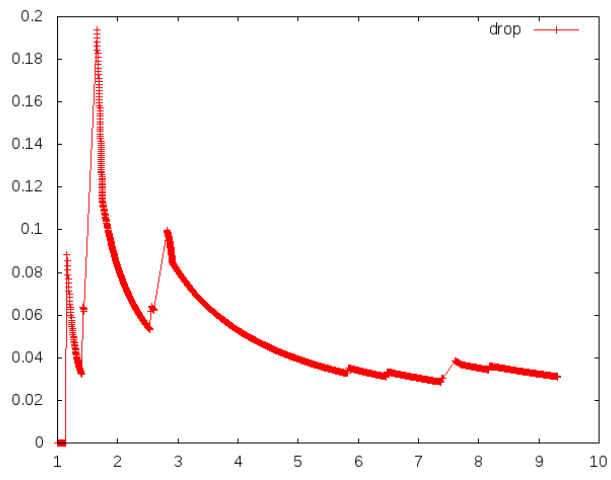
Figure 7. Drop of traditional networks.